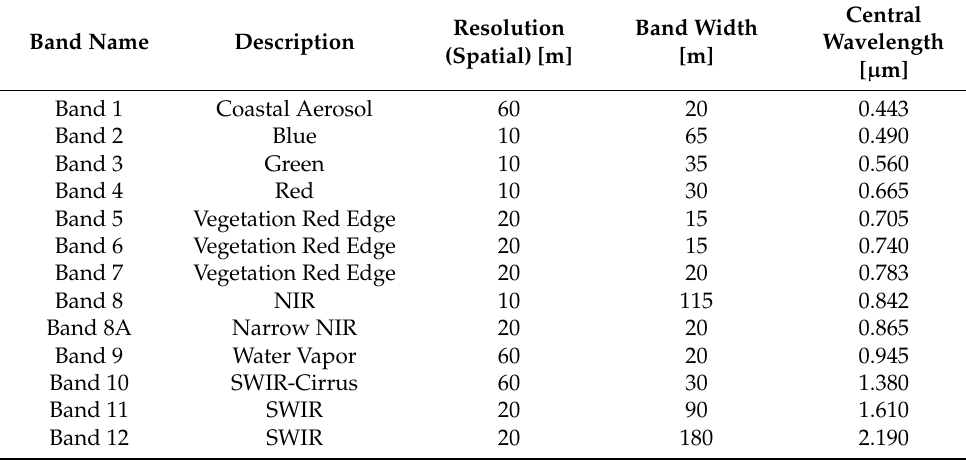
Table 3. List of spectral bands and their characteristics of Sentinel-2